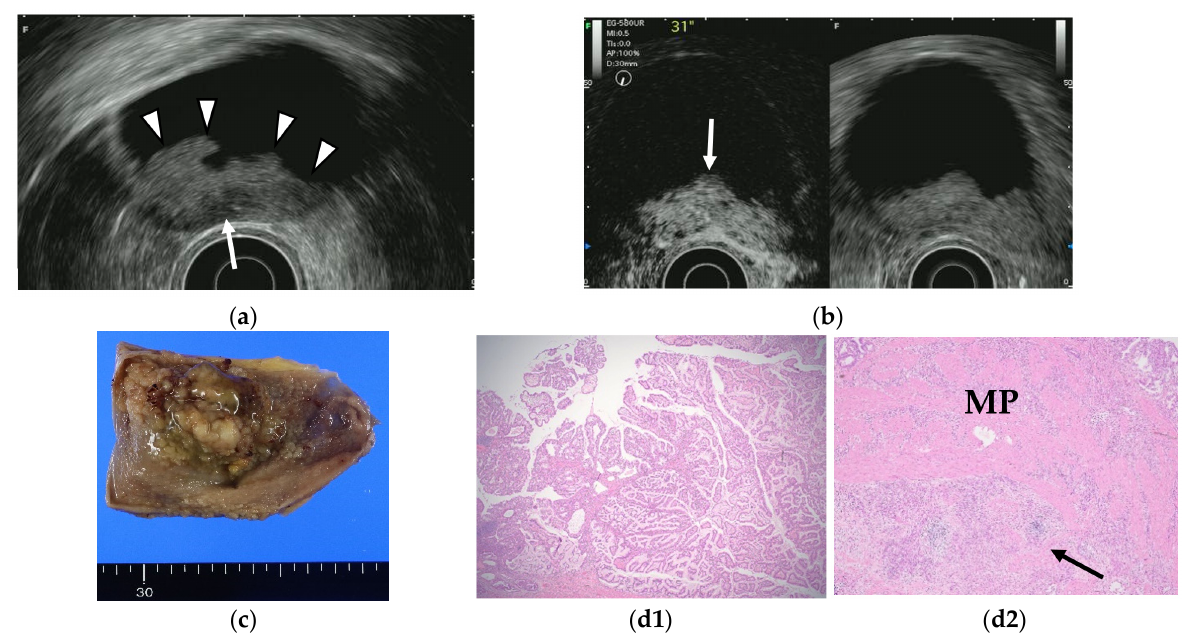
Figure 7. GB carcinoma. ( a ) Conventional EUS shows elevated lesions with conspicuous surface irregularities (arrowheads) observed in the gallbladder body. A hypoechoic region is observed in the deep part of the lesion (arrow), and the outer hyperechoic layer is also irregular, suggesting infiltration into the subserosal layer. ( b ) The contrast- enhanced harmonic EUS image after the injection of Sonazoid ® shows that lesions in the gallbladder body (arrow) have a strong heterogeneous staining effect from the early stage of contrast enhancement. (Left contrast-enhanced harmonic mode, right B-mode) ( c ) Photograph of the gross pathologic specimen after cholecystectomy shows that the papillary neoplasm with a maximum diameter of 55 mm is found from the body to the bottom of the gallbladder. d (1,2): H-E stain of the specimen demonstrates atypical epithelial cells grow papillary. Infiltration into the subserosal layer is observed in a part of the deep part of the tumor with infiltration and hyperplasia of poorly differentiated adenocarcinoma. (MP muscularis propria).